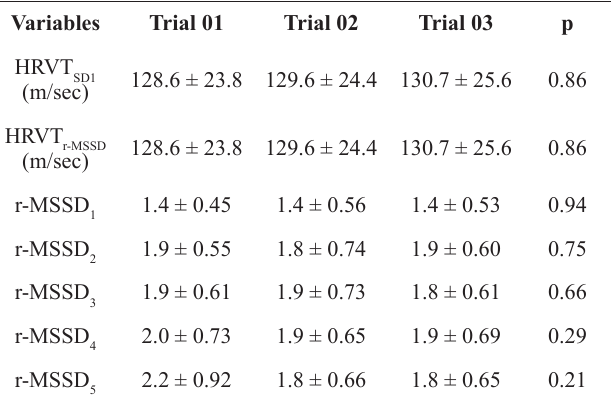
Table 2: The mean and standard deviation of heart rate variability threshold and post-exercise r-MSSD analysis assessed on three oc - casions.